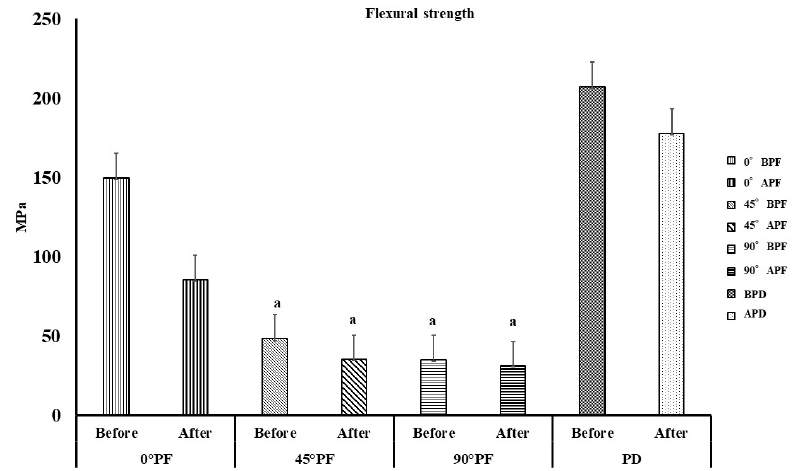
Figure 2. Flexural strength in 3-point bending tests ( p < 0.05, I: 95% confidence interval standard deviation); there is no statistically significant difference between the results indicated by “a”.